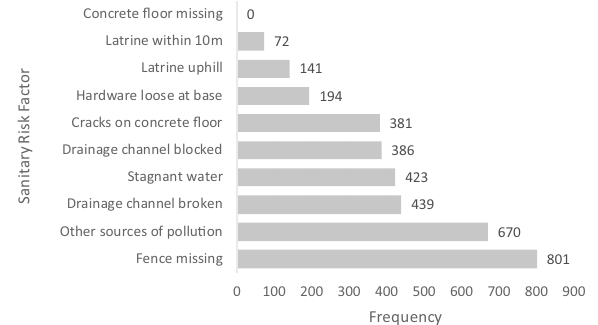
Fig. 2 Frequency of individual sanitary risk factors at 1028 handpumps in sub-Saharan Africa. The number of handpumps at which each risk included on the WHO borehole with handpump sanitary inspection form was present.